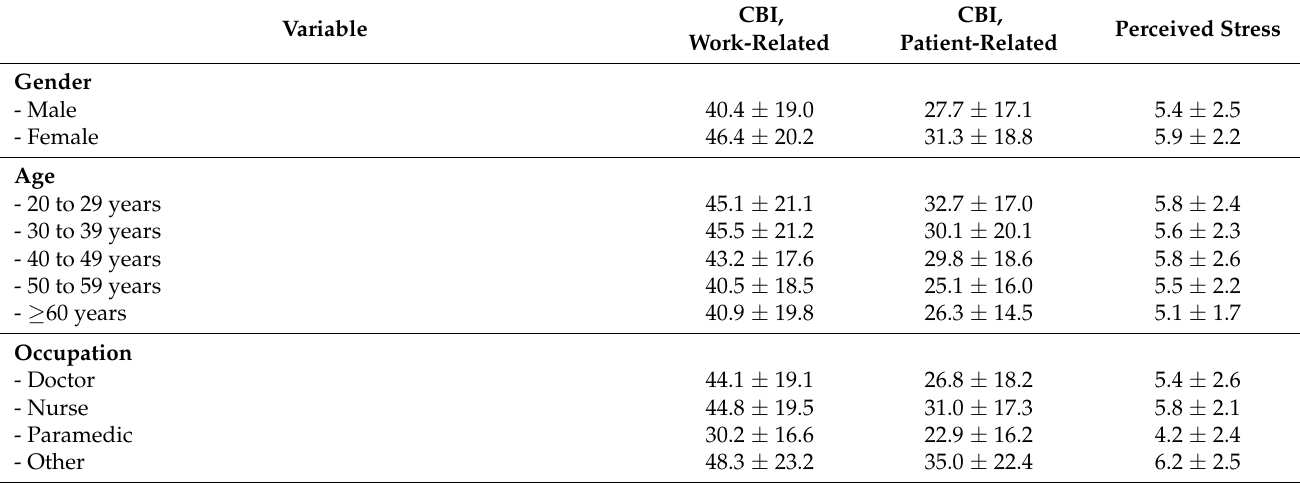
Table 3. Work-related and patient-related burnout and perceived stress according to general characteristics (mean ± SD).